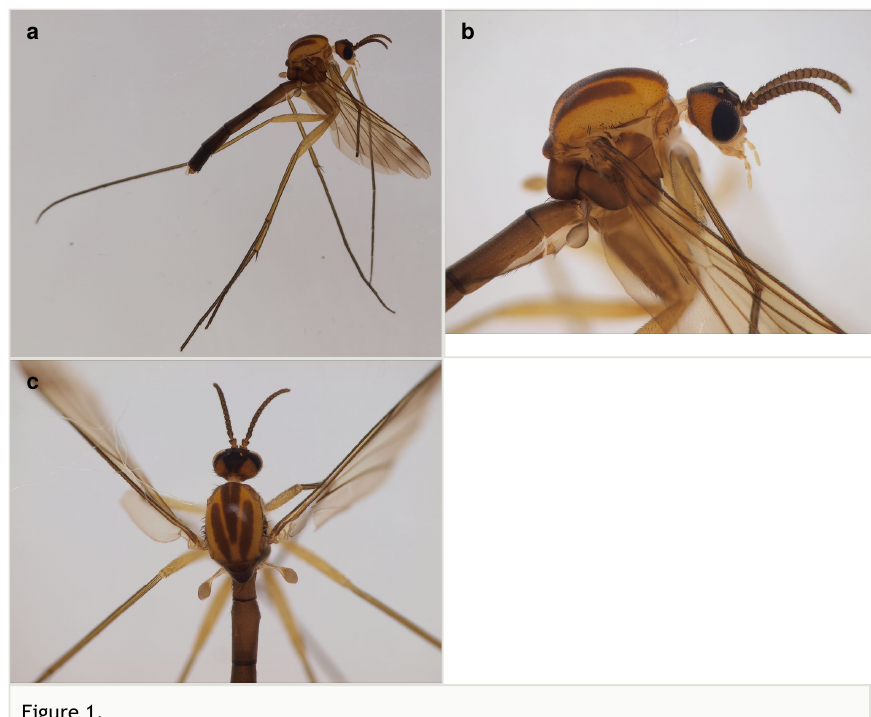
Figure 1. Orfelia boreoalpina Salmela sp.n., holotype male, habitus. a : Habitus, lateral view. b : Thorax and head, lateral view. c : Thorax and head, dorsal Coxae yellowish brown - brown, bearing short dark setae, legs yellowish. Ratio of femur to tibia for fore, mid and hind legs: 0.79, 0.68, 0.63. Ratio of tibia to basitarsus for fore, mid and hind legs: 1.67, 1.0, 1.0. Anterior spur of mid-tarsus about 0.5 times longer than posterior spur. Abdominal tergites and sternites brown, bearing dark setae. Hypopygium brown. 9th tergite widest medially, apex rounded. Gonocoxites dorsally with an outgrowth, bearing a few long apical setae and having a mesial protrusion (Fig. 2a). Cerci prominent, club- like, apically setose, extending to the level of apices of gonostyli (Fig. 2a). Ventral lobe of gonostylus curved, its apical half mostly bare (Fig. 2a, b). Dorsal lobe of gonostylus elongated, pointed in dorsal view, bearing two black subapical long setae (Fig. 2a, b). Aedeagus curved ventrad in lateral view, apex blunt and medially widest in dorsal view (Fig. 2a, b, d). Parameres rod-like, apically dentate (Fig. 2c). Female.The paratype female is lacking all legs except right fore leg and right hind femur. The specimen is slightly paler than the holotype male. The specimen may be somewhat teneral or it has bleached in the Malaise trap or later in the ethanol.